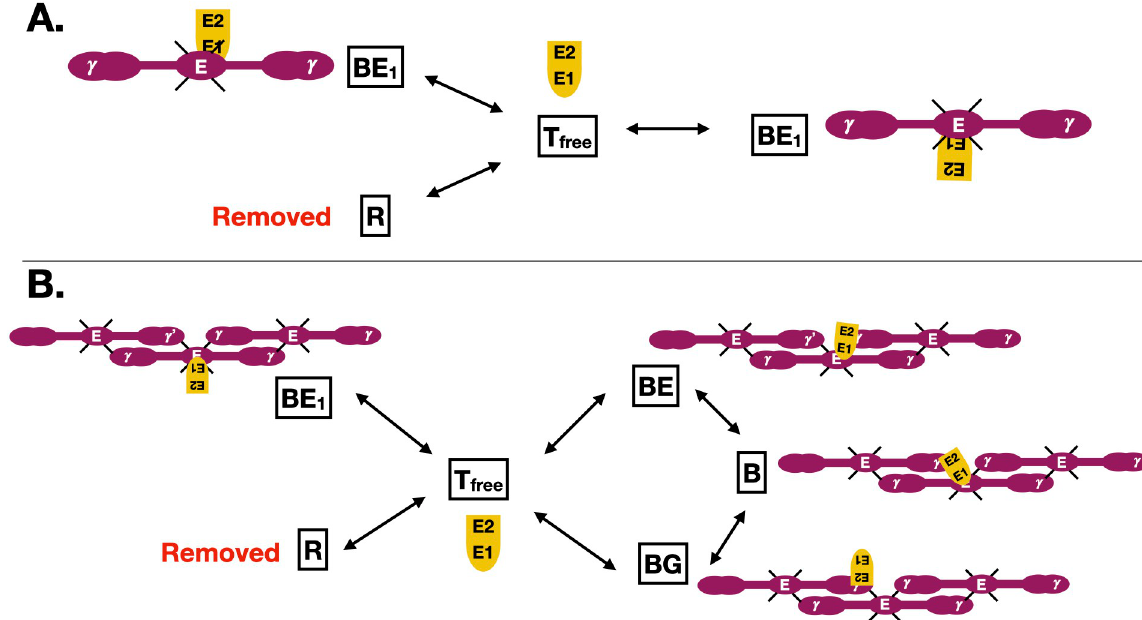
Fig 1. Schematic of single molecule stochastic binding model. (A) A single thrombin molecule binding at a junction of fibrin monomers without bivalent binding (AA junction). Thrombin can be unbound ( T ), bound to fibrin via two E-domain binding sites (BE 1 ), or removed free from the system (R), which is an absorbing (end state). Thrombin is in yellow, fibrin in purple, and red is the removed state. (B) A single thrombin molecule binding at a junction of fibrin monomers with bivalent binding (AP junction). Thrombin can be unbound ( T ), bound to free fibrin via two E-domain binding sites (BE 1 and BE), bound to a single γ 0 binding site (BG), or can transition from BE and BG to the bivalently bound state (B), or can be removed from the system to state (R), an absorbing (end